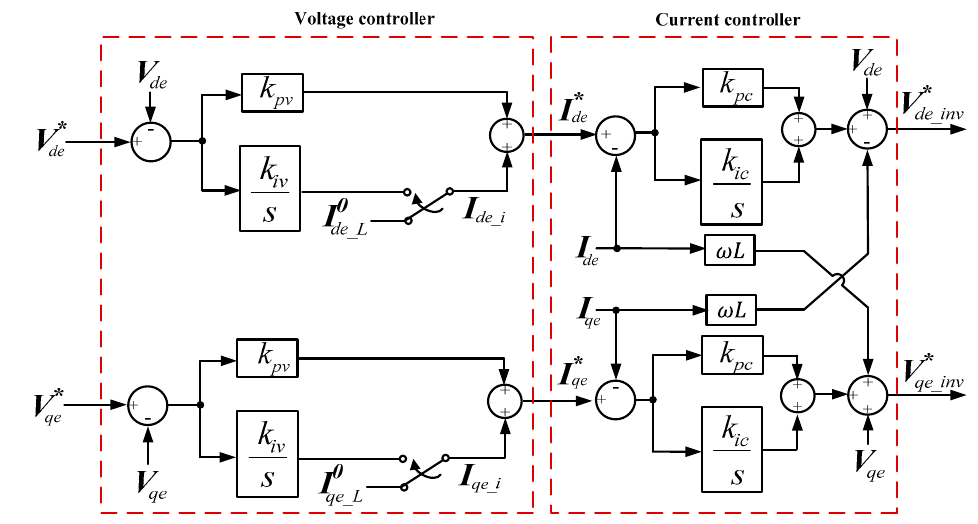
Figure 8. Proposed control block diagram for BESS.